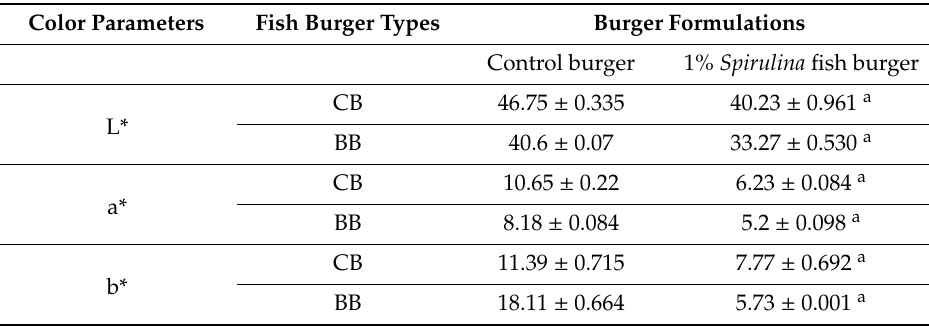
Table 5. Color analysis of control burgers and Spirulina -fortified